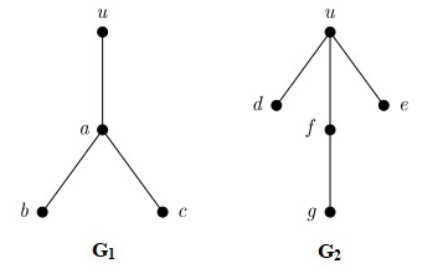
Figure 5. Trees G 1 and G 2